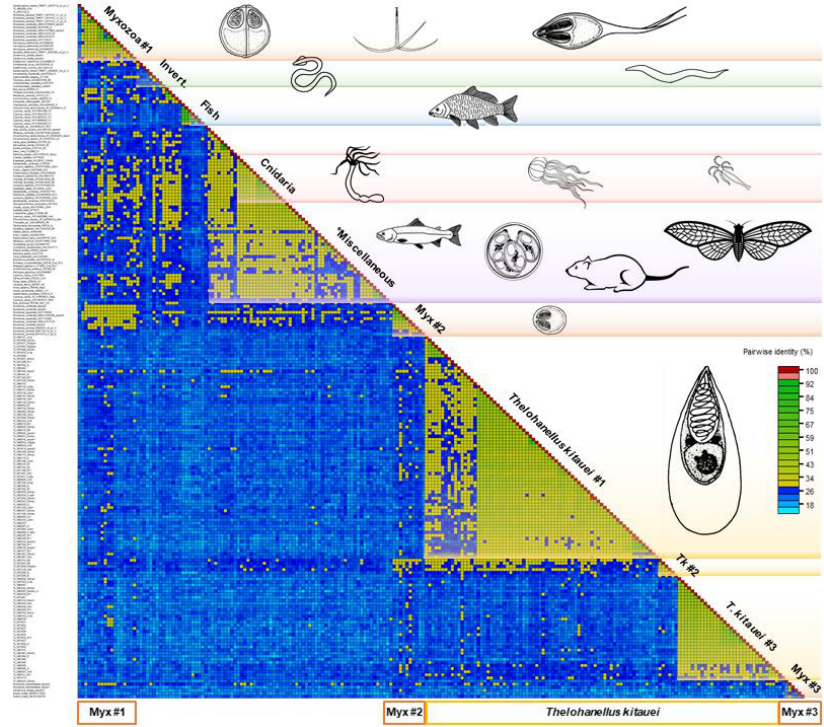
Figure 1. Pairwise sequence identity matrix of 224 serpin sequences using Sequence Demarcation Tool v1.2. Cut-off values: 29% and 95%. Blue squares represent sequence identity below 29%, green squares 29–94%, red ≥ 95%. The length of the protein sequences varied between 127 and 518 amino acid. Myxozoan groups #1, #2, and #3 contain a variety of myxozoan serpins ( Myxobolus cerebralis, M. pendula, M. pseudodispar, M. squamalis, Ceratonova shasta, Sphaerospora molnari, Myxidium lieberkuehni, Kudoa iwatai, Henneguya salminicola ), except the ones of Thelohanellus kitauei . *Miscellaneous: sequence identity group composed of protists, invertebrates, and